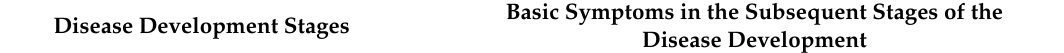
Table 2. Presentation of the basic symptoms accompanying di ff erent stages of the development of plaque